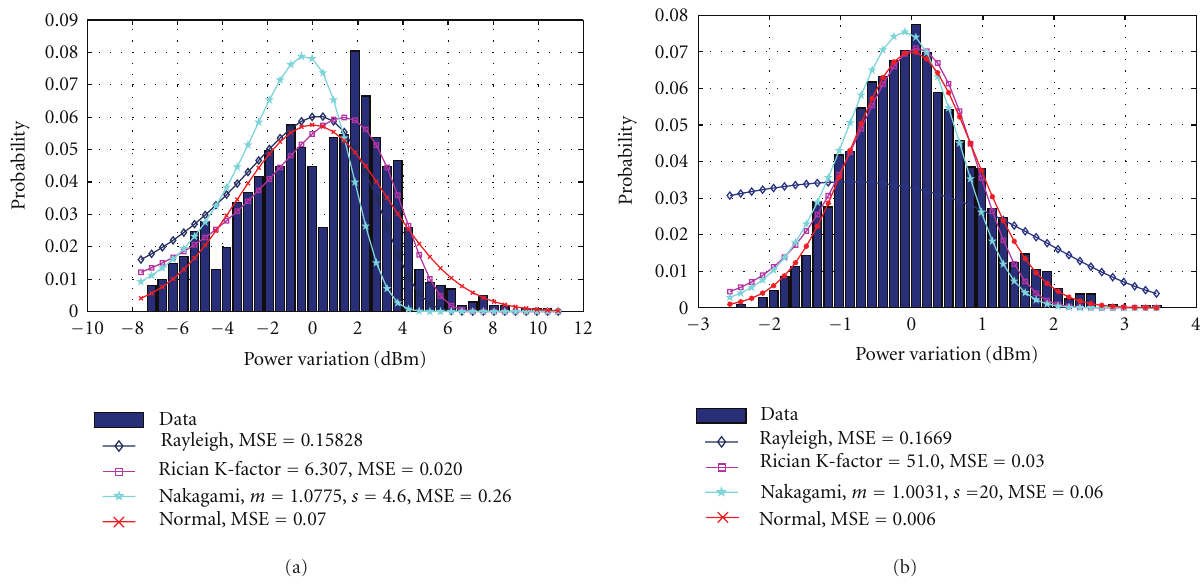
Figure 6: Probability density function of small-scale variation at 1.3GHz (a) with people and (b) without people, in the room.